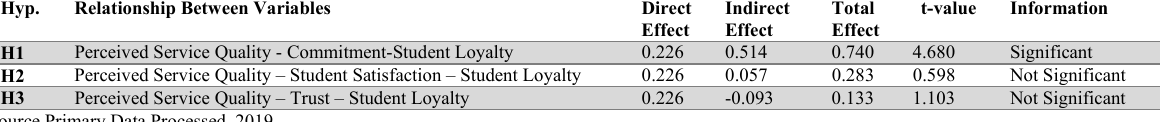
Testing of Indirect Influence